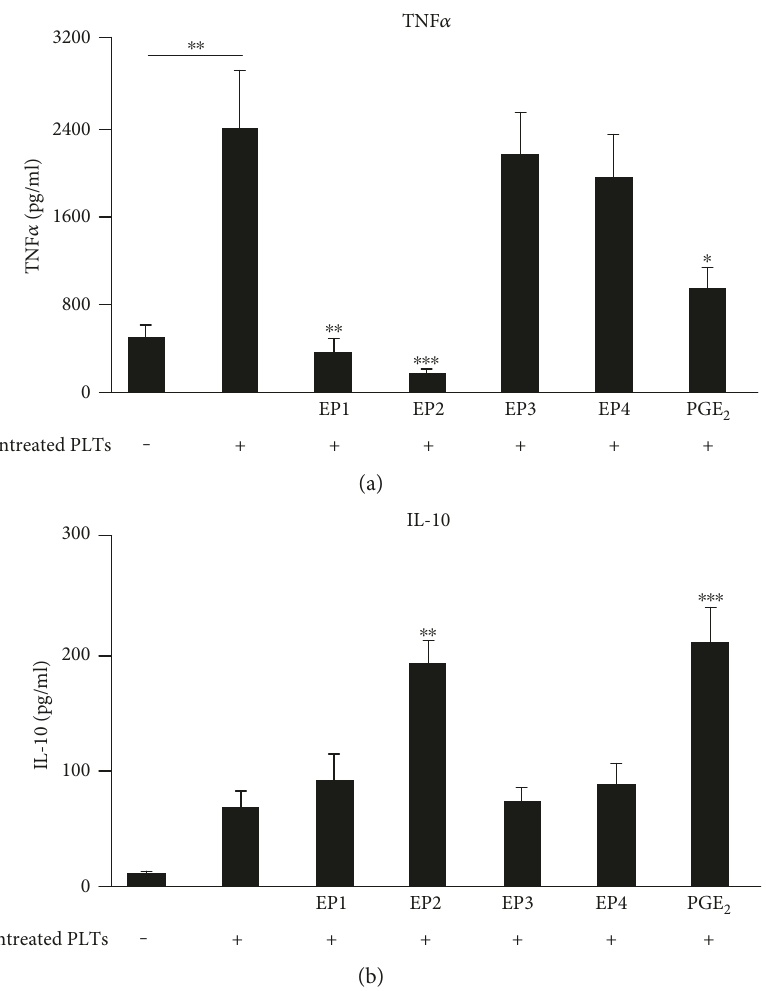
Figure 7: In fl uence of EP receptor agonists on the release of TNF α and IL-10 from platelet-stimulated human monocytes. Human monocytes were incubated alone or with untreated platelets and the respective EP agonist concentrations for 3 hours (400nM ONO-Di-004, 170 nM ). TNF α (a) or IL-10 (b) were determined by ELISA. Data are presented as butaprost, 10nM sulprostone, 5 nM L-902,688, 1 μ M PGE 2 mean ± SEM from 4 experiments. One-way ANOVA/Bonferroni ∗ P < 0 05 , ∗∗ P < 0 01 , ∗∗∗ P < 0 002